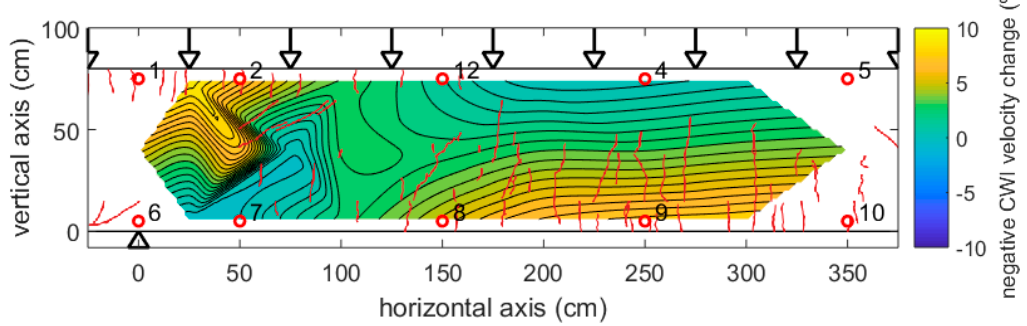
Figure 16. Girder DLT 1.5: Velocity change due to line load (170 kN at each point), revealed by step-wise CWI and interpolations between positions of transmitter receiver pairs. Arrow: Loading points. Triangle: central support. Red lines: cracks visible at surface.